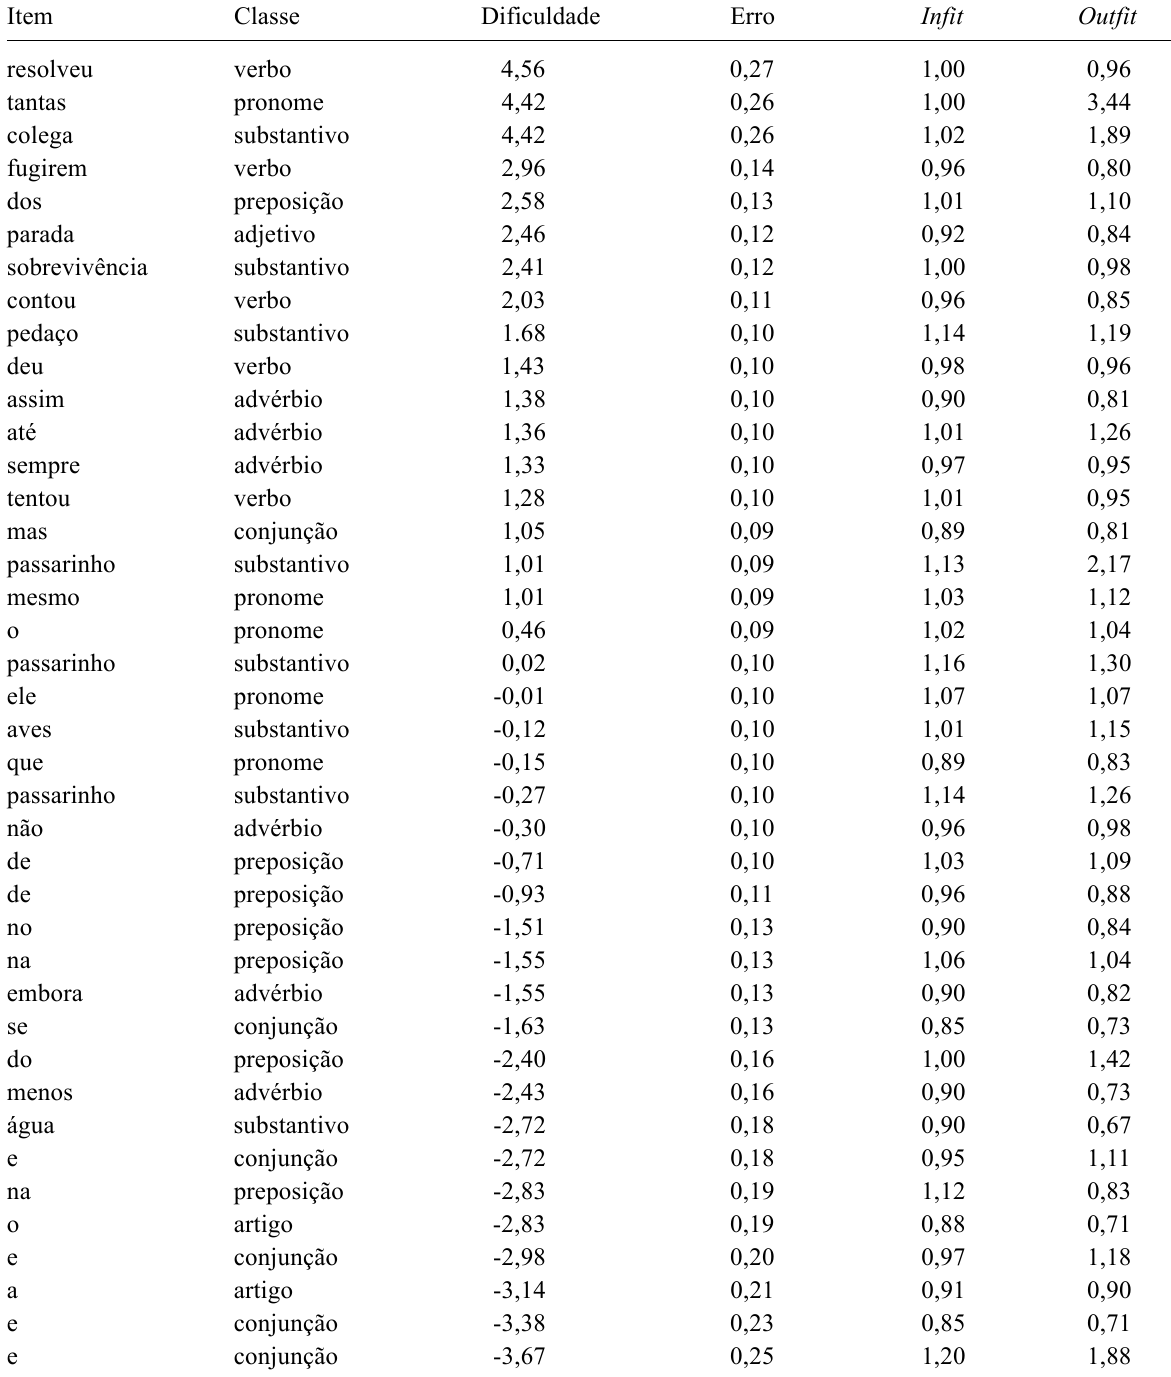
Distribuição do Ajuste dos Itens ao Modelo